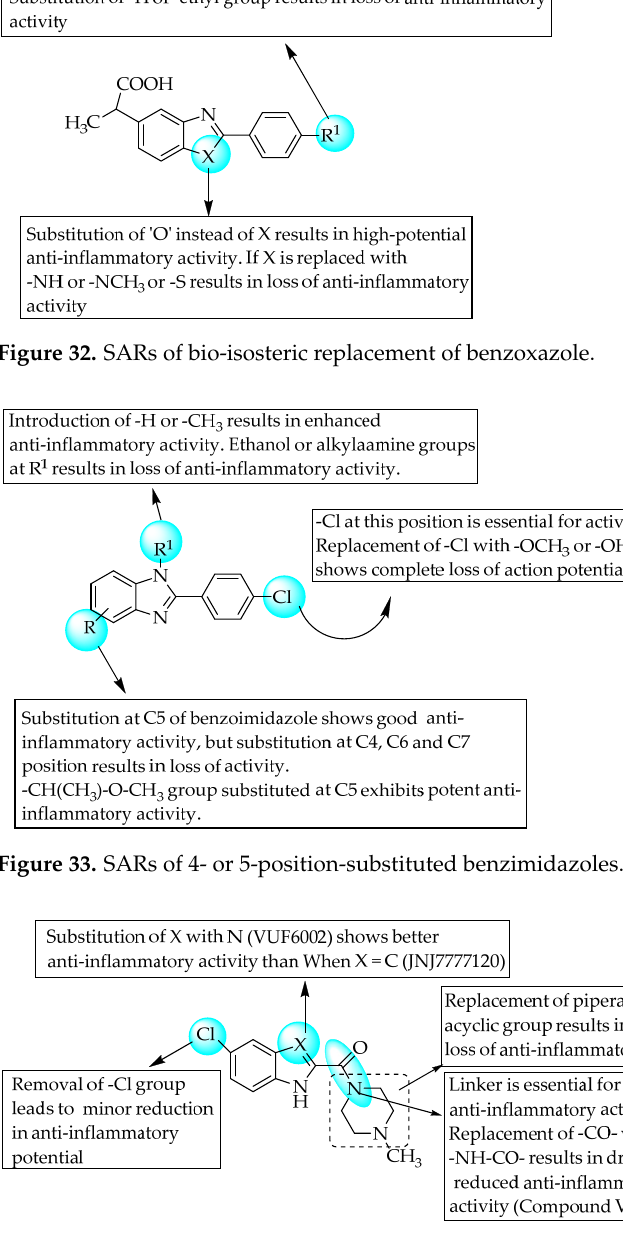
Figure 35. SARs of adamantane-substituted benzimidazoles. The compound 2-cyclohexylamino-1(4-methoxyphenyl)benzimidazole exhibited potent anti-inflammatory activity according to Taniguchi et al. (1993) [55]. The an- ti-inflammatory activity of the compounds at 100 mg/kg p.o. doses was evaluated using the carrageenan-induced rat paw oedema model. 2-cyclohexylamino-1 (4-methoxy phe- nyl) benzimidazole exhibited 53.2% inhibition of rat paw oedema. Replacing the amino group with methylene at C2 of benzimidazole significantly reduced the activity, indi- cating the significance of the guanidine fraction in the activity. Moreover, a bulkier aro-